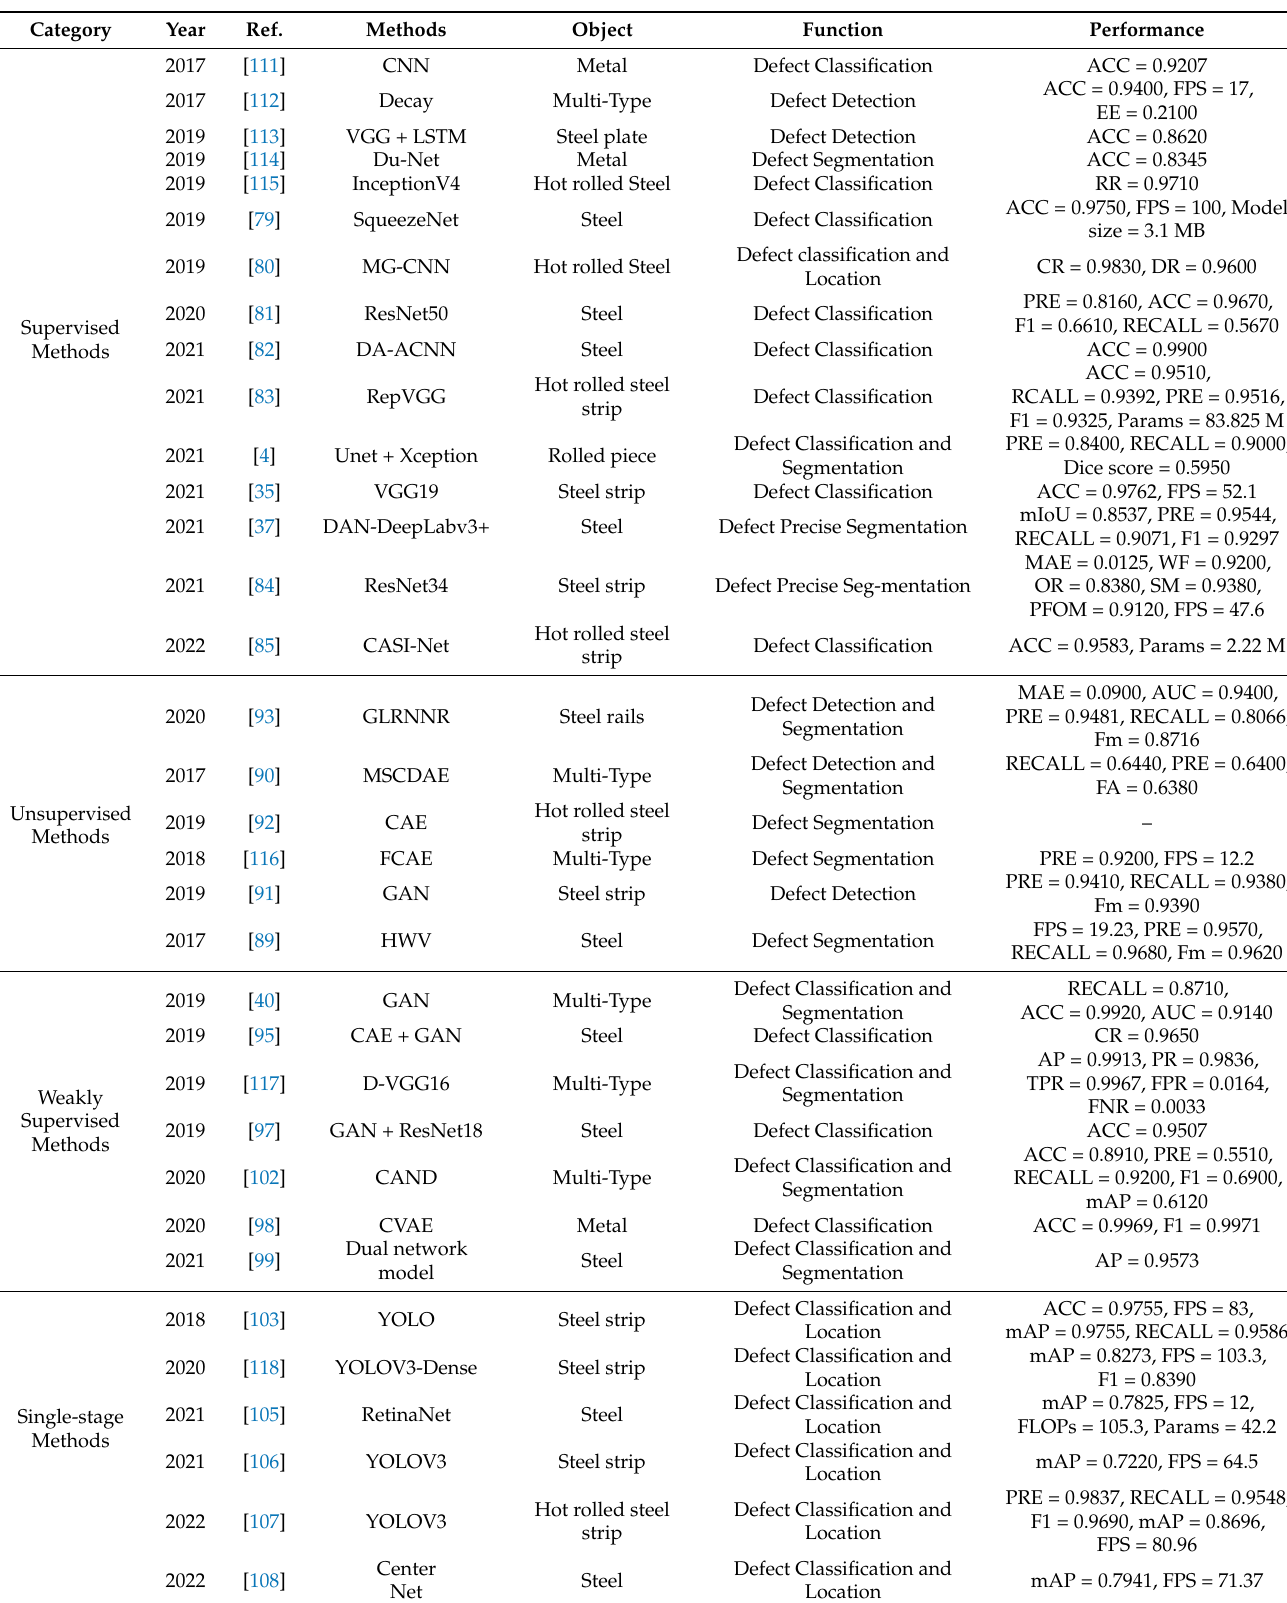
Table 5. Summary of deep learning-based